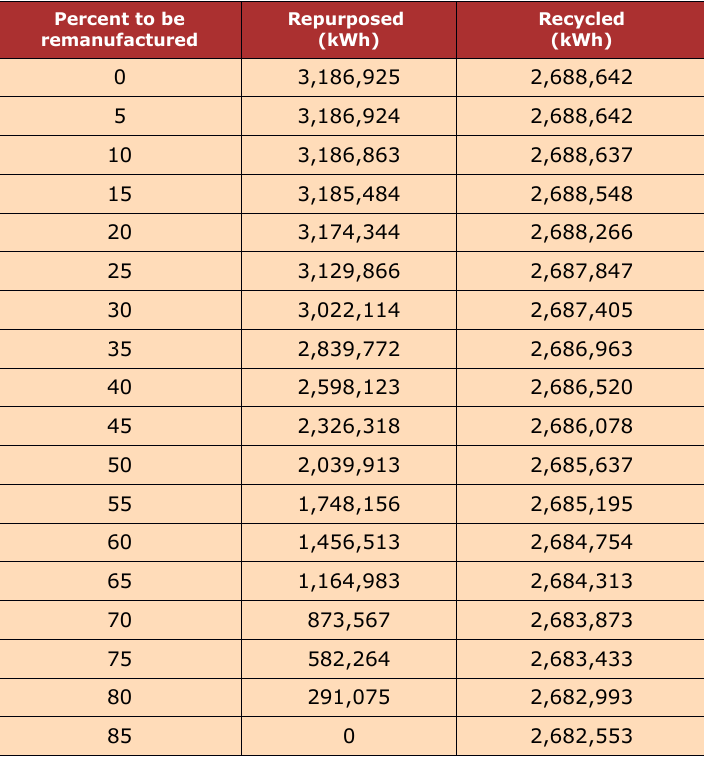
Table 8. New and remanufactured batteries by